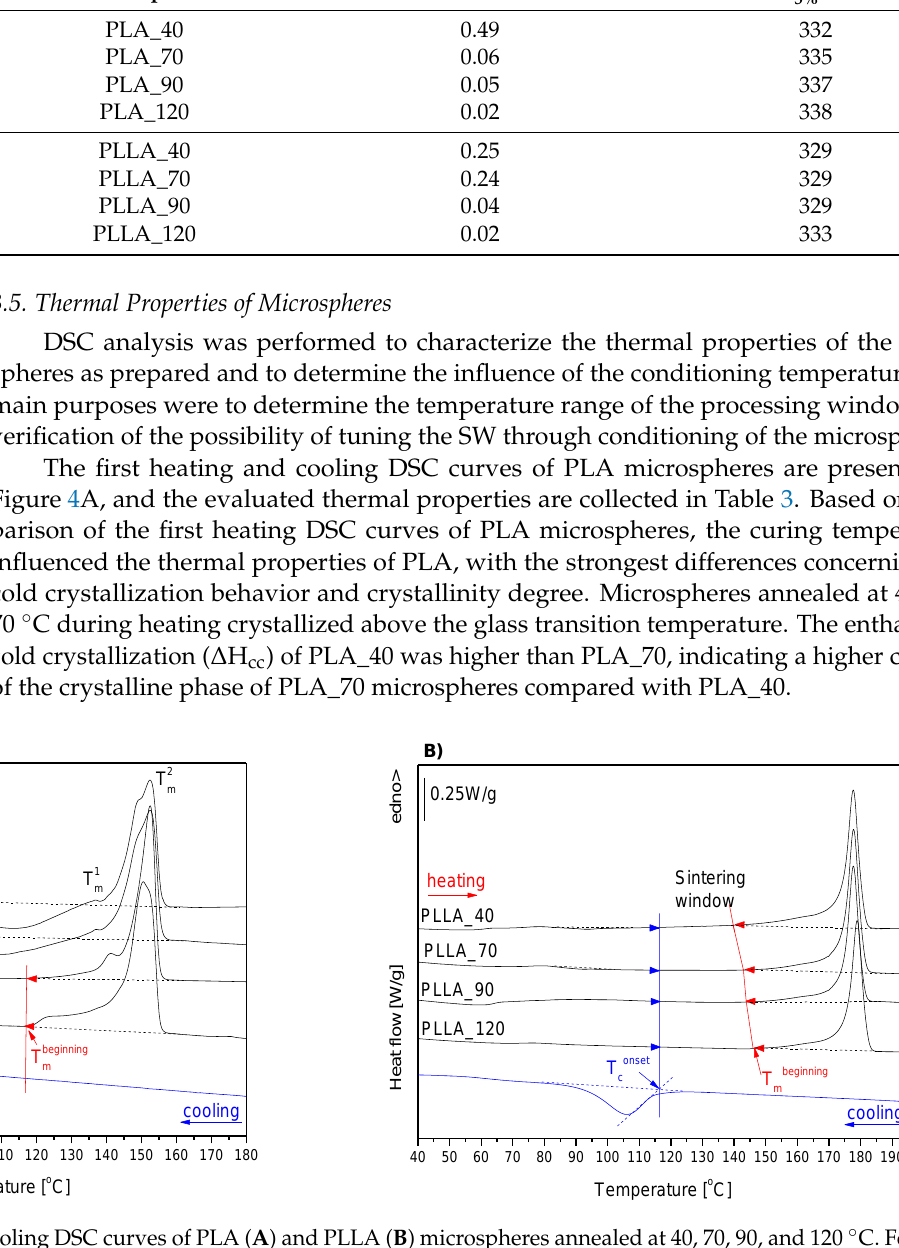
Figure 4. First heating and cooling DSC curves of PLA ( A ) and PLLA ( B ) microspheres annealed at 40, 70, 90, and 120 °C. For simplicity, only one cooling curve recorded after the complete melting and isotropization of PLA and PLLA microspheres is presented on the A and B graphs, respectively. The cooling curves of the series of PLA as well as PLLA microspheres were similar within series independently regarding the annealing temperature (Figure S3 in the Supplementary Materials).